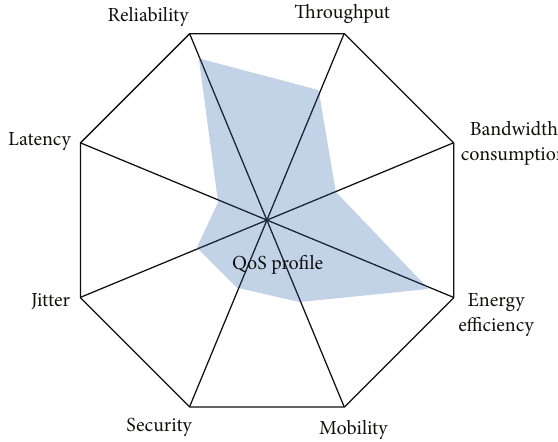
Figure 2: Quality of Service (QoS) parameters in WMSNs.